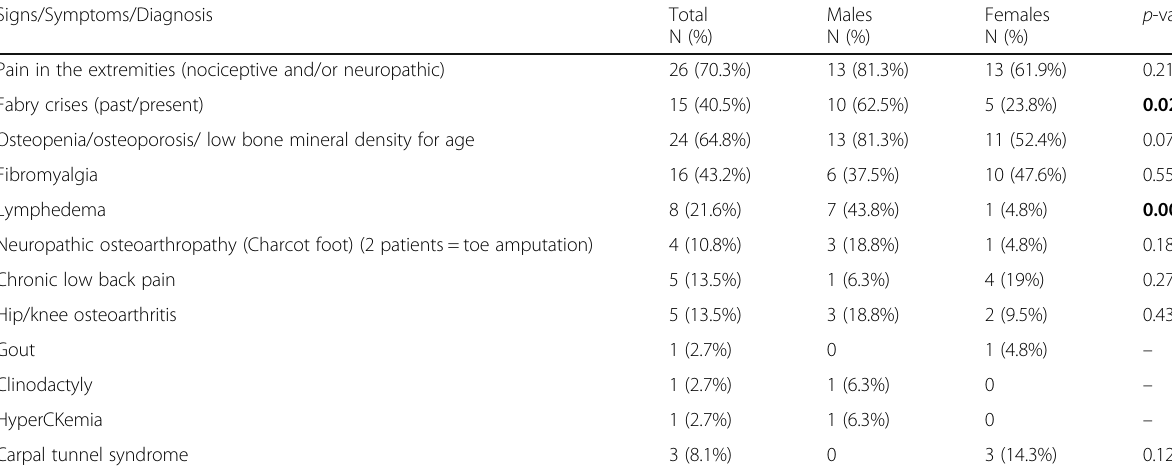
Table 3 Rheumatic manifestations in Fabry disease